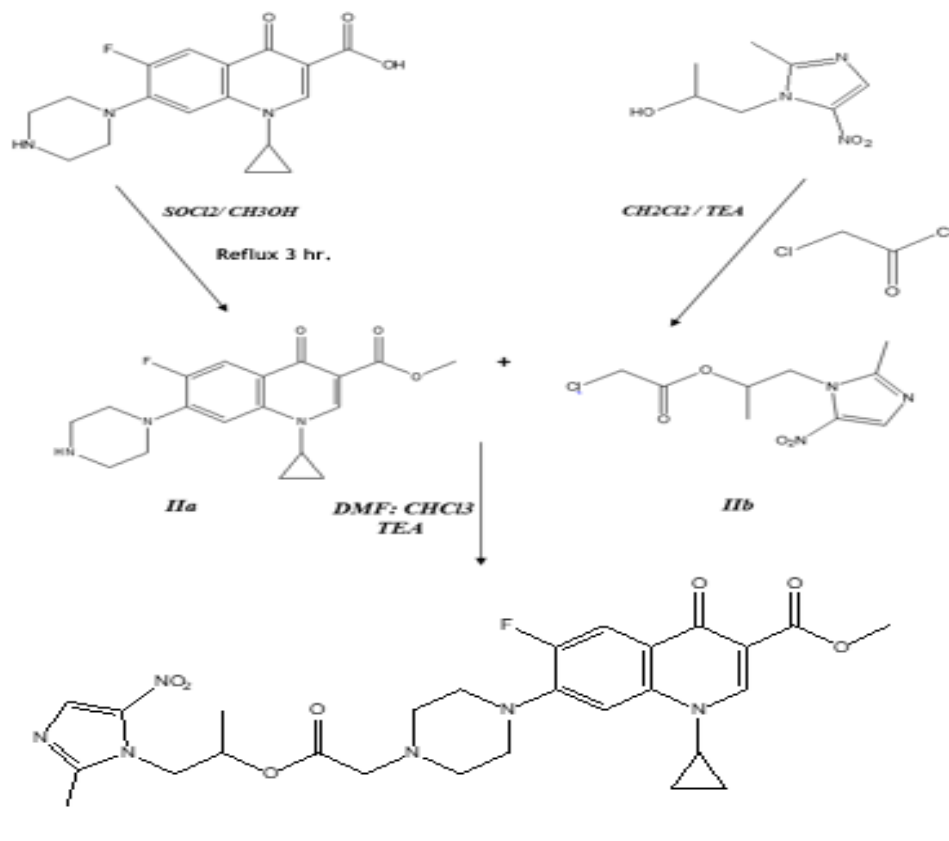
Table 1. Spectral characterization of synthesized mutual prodrugs